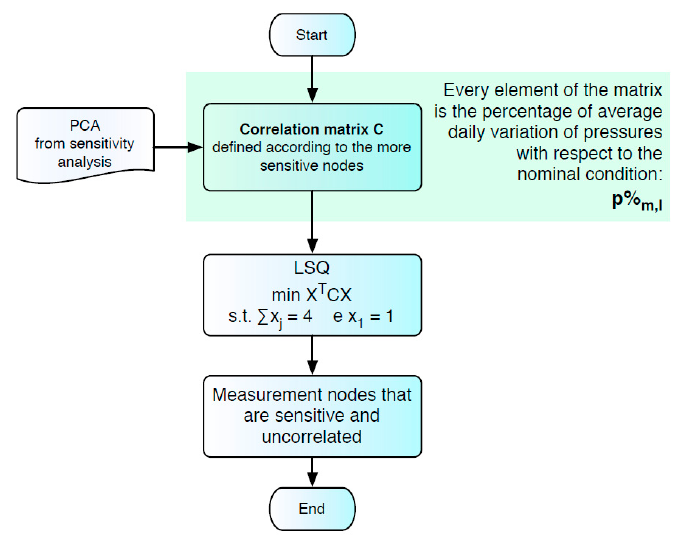
Figure 6. Algorithm scheme of the correlation analysis.